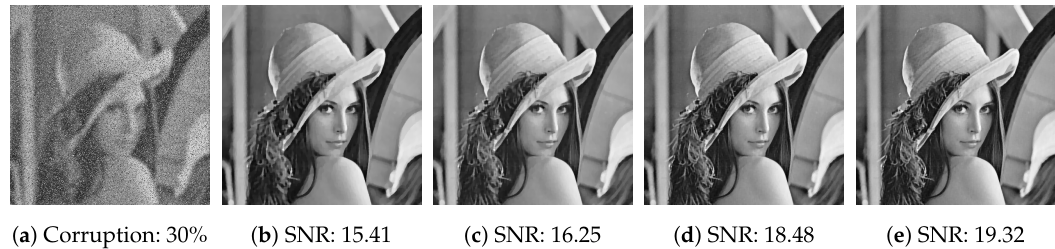
Figure 12. Comparisons of TVL1, HTVL1, CTVL1 and HOCTVL1 model on the Lena image corrupted by Gaussian blur and random-valued noise with noise level 30%. ( a ) Corrupted image. ( b ) TVL1 model. ( c ) HTVL1 model. ( d ) CTVL1 model. ( e ) HOCTVL1